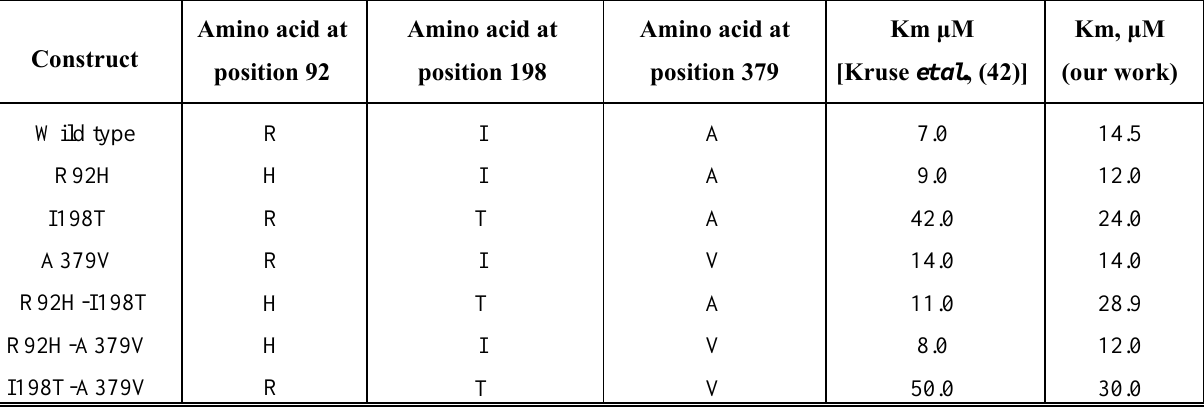
Table 2. Affinity of wild-type, human PAF-AH and several variants for